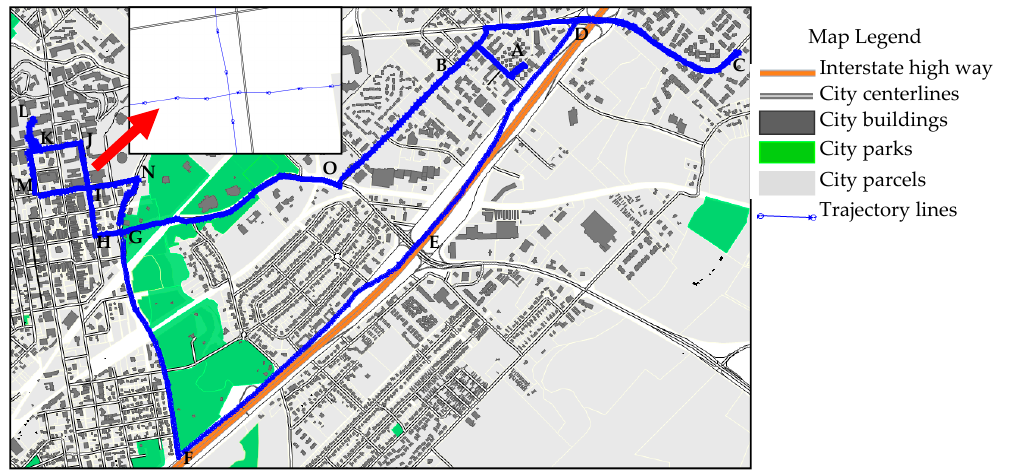
Figure 6. A GPS trajectory of 2010 points with mixed transportation modes. The subject began the trip from point A, walked to point B, and then took a bus traveling along the route of B → D → C → D → E → F → G → H → I → J → K. The subject got off the bus at point K, walked to point L and back to K, and then took bus along the route of K → M → I → N → G → O → B. The subject got off the bus at point B and walked back to point A. The enlarged window shows the bus station at point B and the nearby GPS trajectory points.